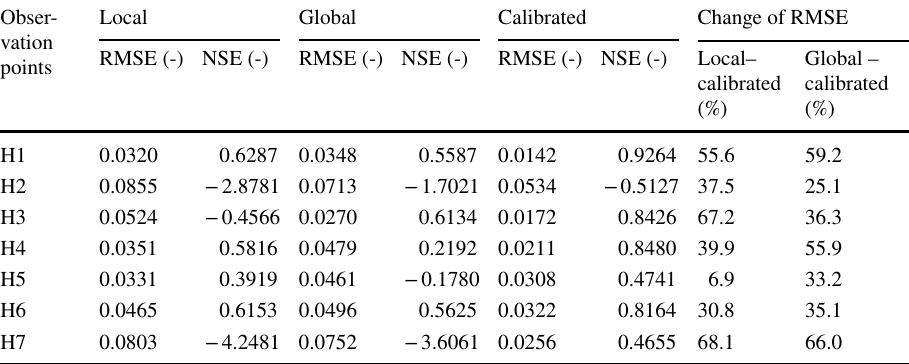
observation regarding water content by using hydraulic soil parameters originating from local, global and calibration measurements—soil